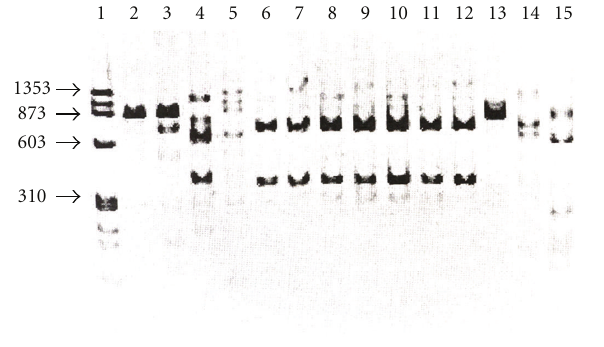
Figure 2: PCR Amplification of kDNA with the primers AJS 1 and DeB 8. Lane 1, MWMX174 Hae III; 2, L. (L.) granhami JAP78; 3, L.